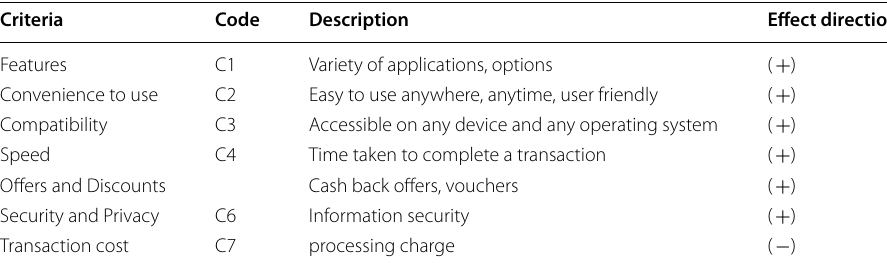
Table 3 List of